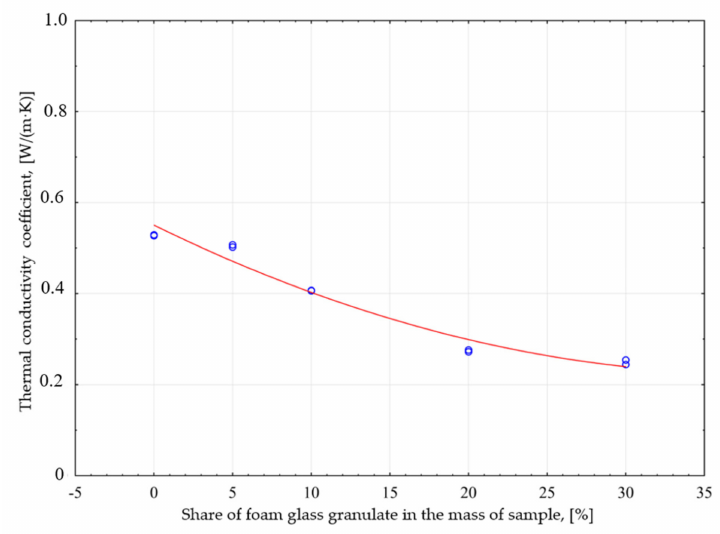
Figure 5. Influence of the GFG content of 0.25–0.5 mm fraction in the sample weight on the thermal conductivity of the tested samples.